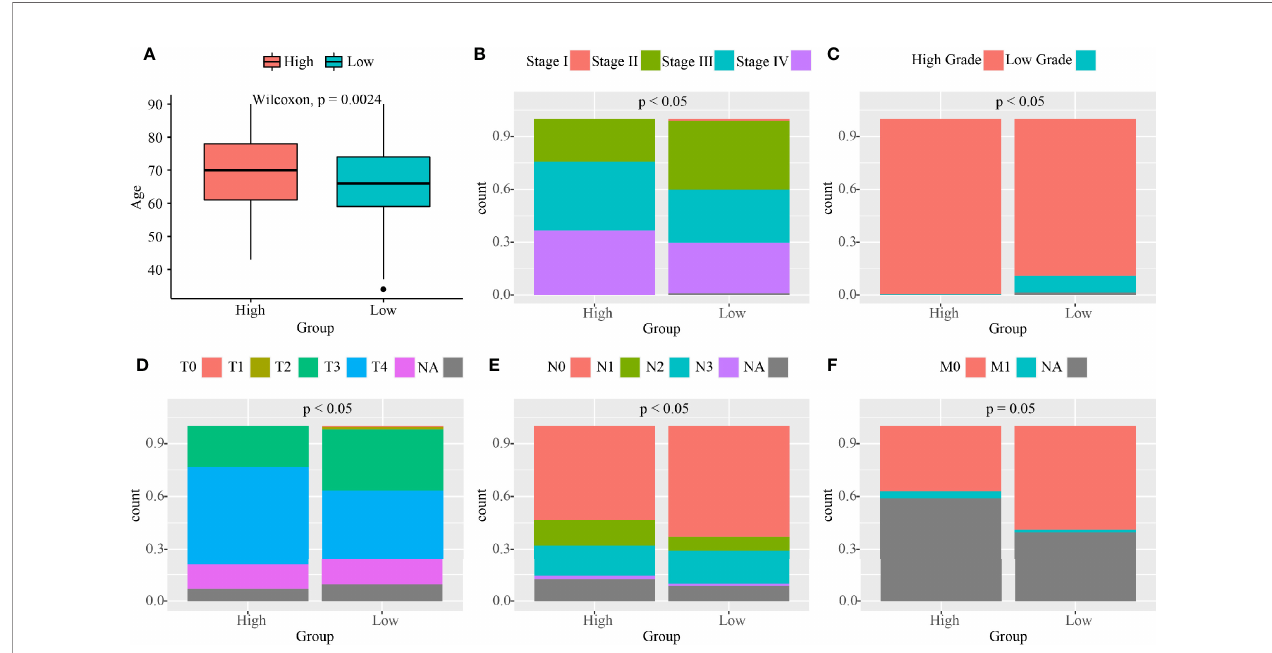
FIGURE 6 | The analyses of clinical features between the high and low nuclear MTRGs score groups from the TCGA cohort. (A) Boxplots exhibit the age at diagnosis for the high and low nuclear MTRGs score groups (p=0.0024). Percentage-staked bar plots show the distribution of BC patients with the different clinical stage (B) , histological grade (C) , tumor stage (D) , lymph node status (E) , and tumor metastasis (F) between the high and low nuclear MTRGs score groups (p<0.05 was considered as signi fi cant; NA, not